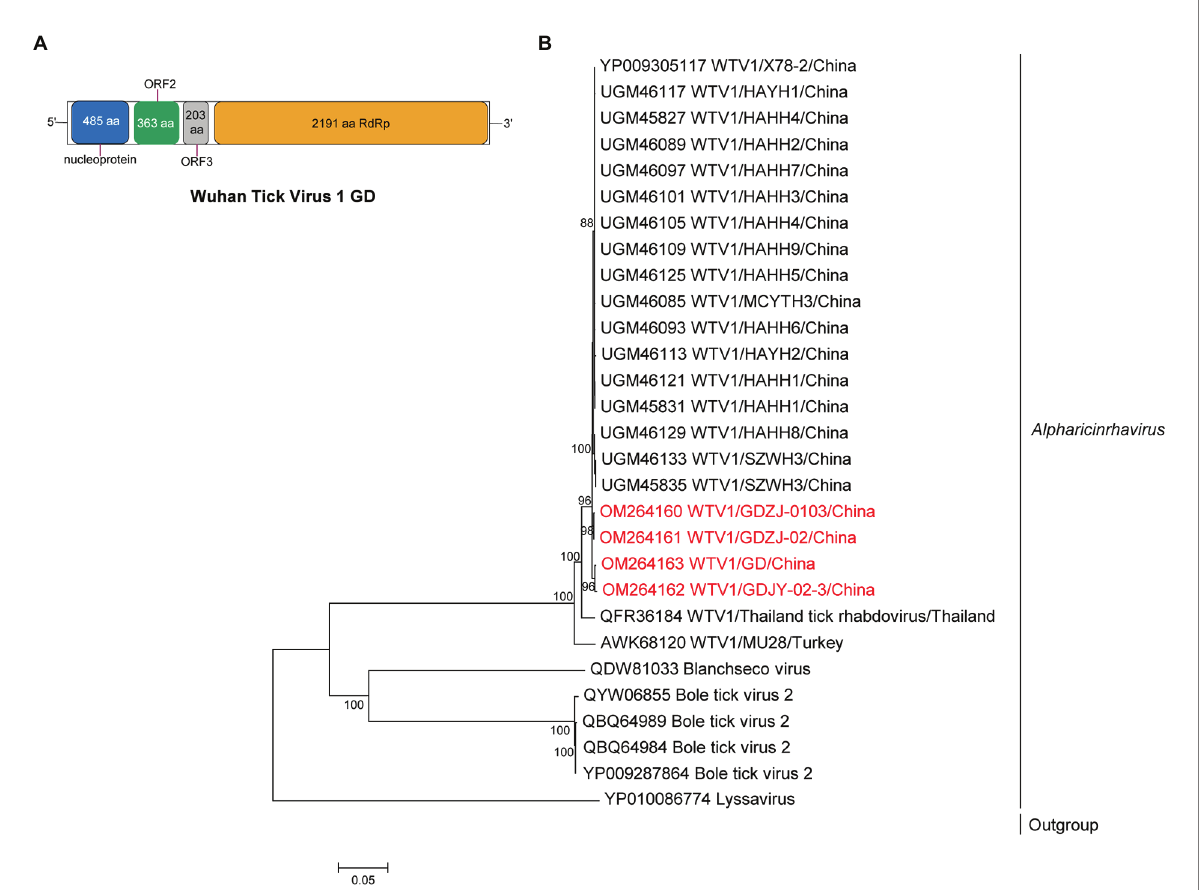
FIGURE 3 The genome structure and phylogenetic analysis of alpharicinrhaviruses. (A) Genome organization and putative coding regions of Wuhan tick virus 1 (WTV1). The viral genome contains one segments that encoding the nucleoprotein (N), ORF2, ORF3, and RdRp. (B) Phylogenetic analyses of alpharicinrhaviruses. Phylogenetic trees were constructed based on the RdRp protein sequences of representative viruses in the genus Alpharicinrhavirus . Viruses obtained in ticks here are highlighted in red. Scale bar indicates nucleotide substitutions per